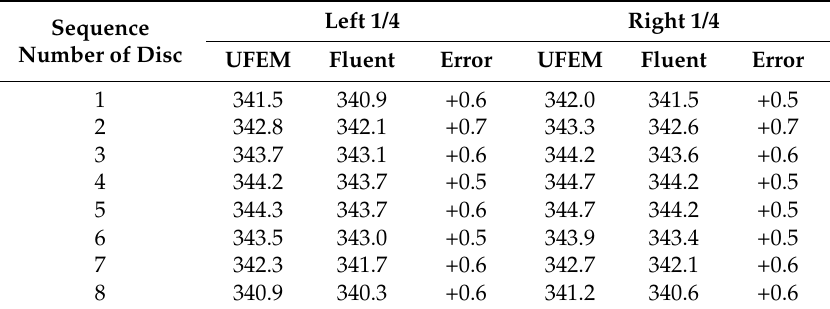
Table 3. Average temperature of discs calculated by Fluent and the UFEM (K).